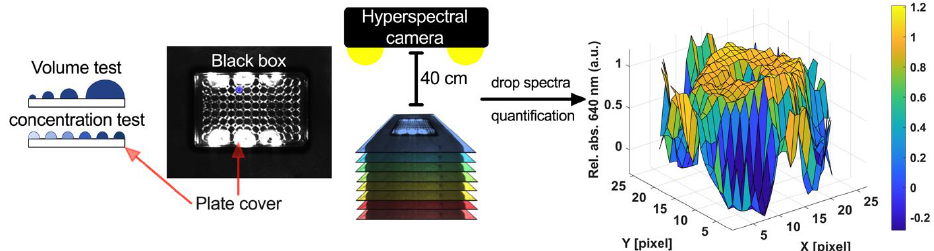
Figure 1. The relative absorbance of the drops (labeled antibody dissolved in PBS) was collected with the HSI camera and used to quantify Ab. Sampling drops at different volumes and concentrations were placed on the cover of a transparent 96-well plate in a black box at a 40 cm distance from the Hyperspectral camera. The distance (40 cm) is set up by the manufacturer to guarantee LFOV during the surgical procedure.